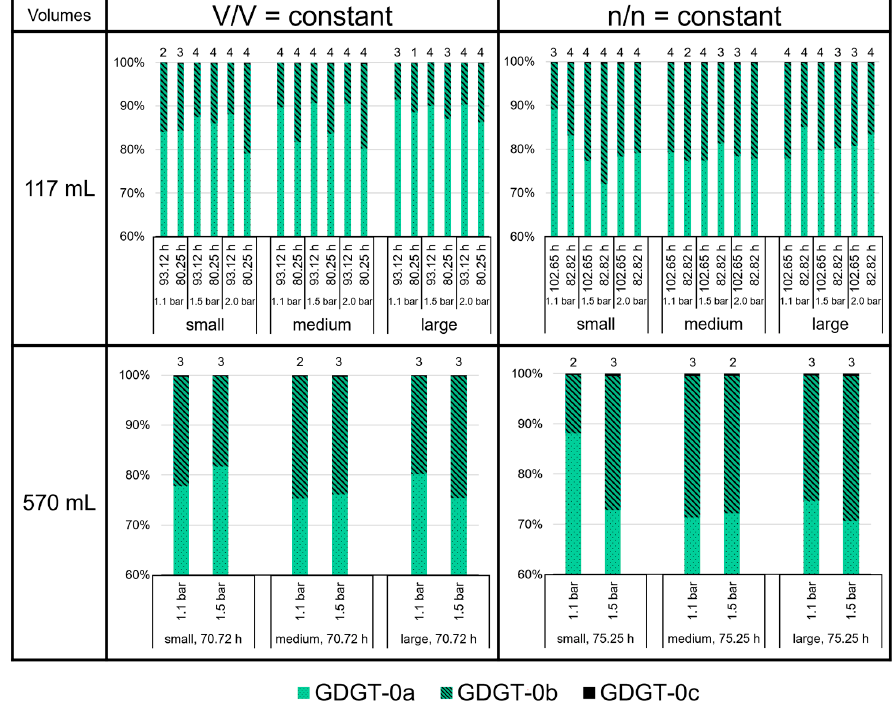
Figure 7. GDGT lipid (GDGT-0a, GDGT-0b, and GDGT-0c) ratios in M. marburgensis cultures. Pressure is given in bar relative to atmospheric pressure. Numbers above bars indicate number of samples. Samples quantified with 5- α -cholestane standard are indicated in Tables S4–S9.